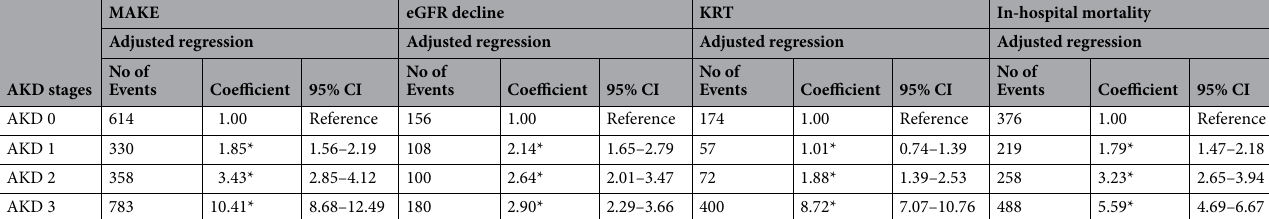
Table 2. Association between AKD stage and major adverse kidney events among all patients. Adjustment: age, sex, hypertension, heart disease, diabetes, anemia, cerebrovascular disease, cancer, COPD and digestive tract disease. AKD acute kidney disease, MAKE major adverse kidney event, eGFR estimated glomerular filtration rate, KRT kidney replacement therapy. * P <